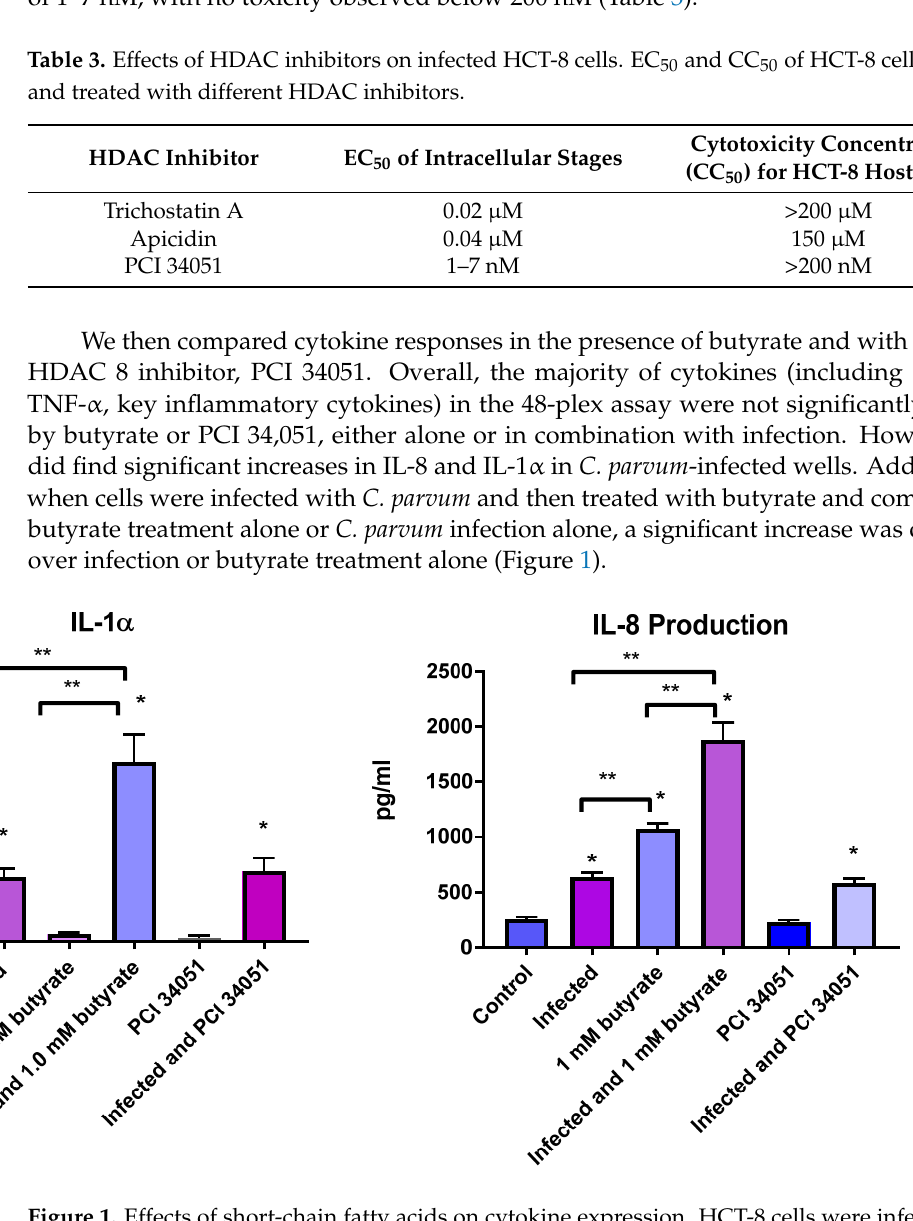
Table 3. Effects of HDAC inhibitors on infected HCT-8 cells. EC 50 and CC 50 of HCT-8 cells infected and treated with different HDAC inhibitors.